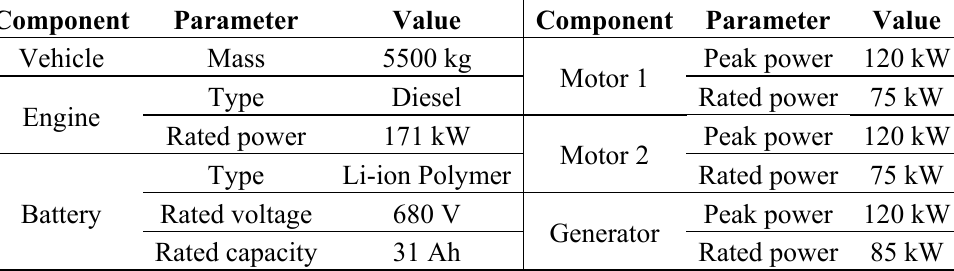
Table 3. Vehicle parameters.